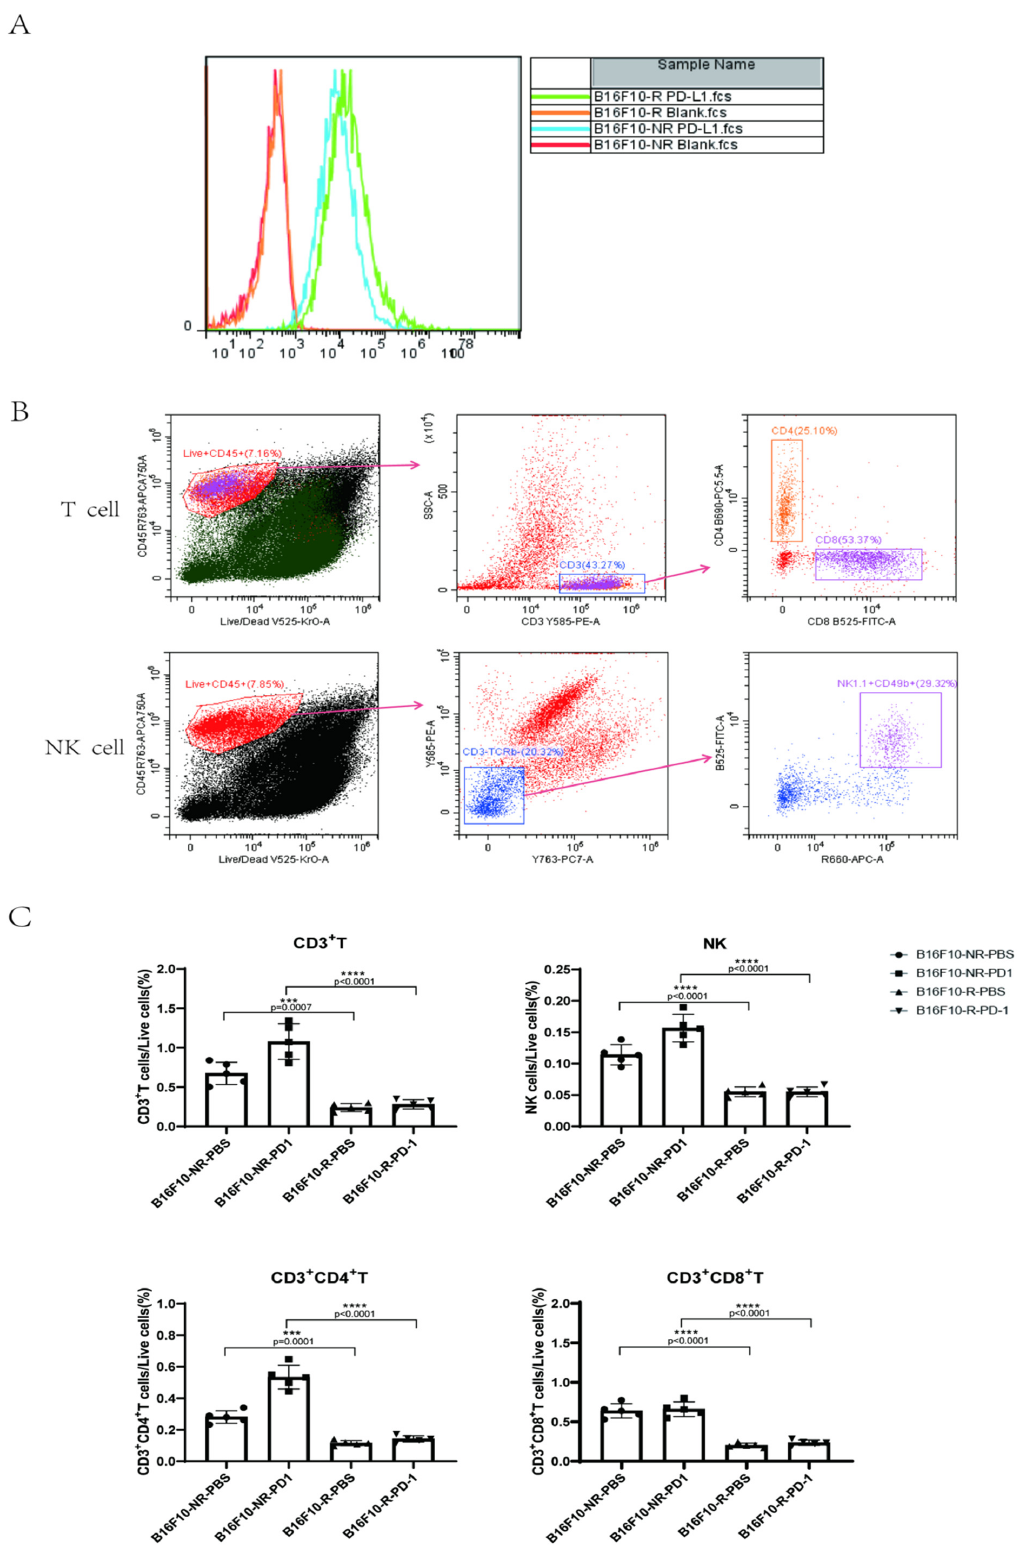
Figure 2. Differences between B16F10-NR tumour and B16F10-R tumour cells. ( A ) PD-L1 expression on the surface of B16F10-NR and B16F10-R cells. ( B ) Gating strategy to identify intratumoural T and NK cells. ( C ) Differences in the number of infiltrating lymphocytes in the TME of B16F10-NR tumours and B16F10-R tumours (one-way ANOVA test, Tukey); ns, not statistically significant; *** p < 0.001; **** p <